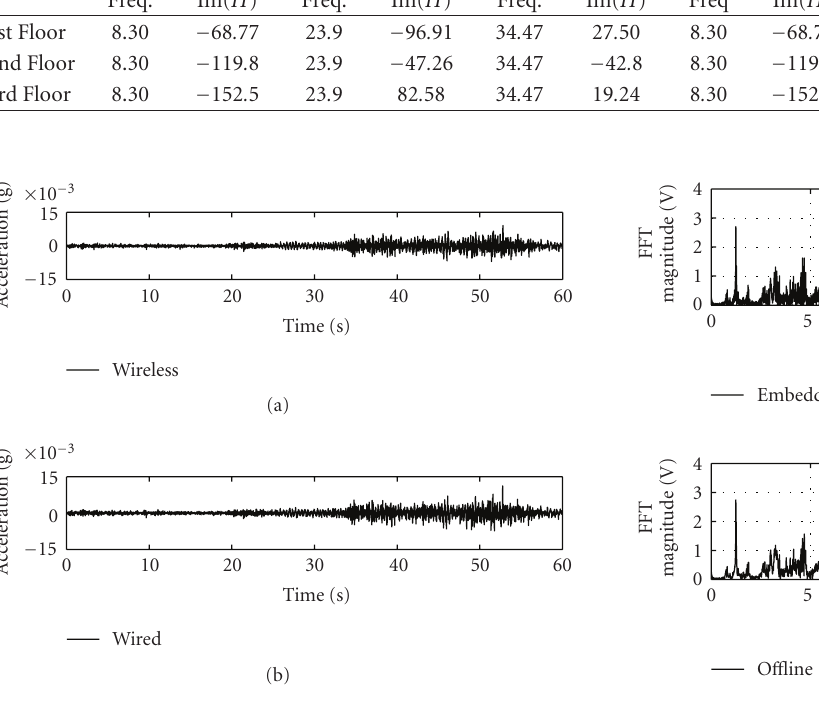
Figure 8: Comparison of FFT results at sensing node 5. (a) Embedded using the wireless sensing unit. (b) O ffl ine by